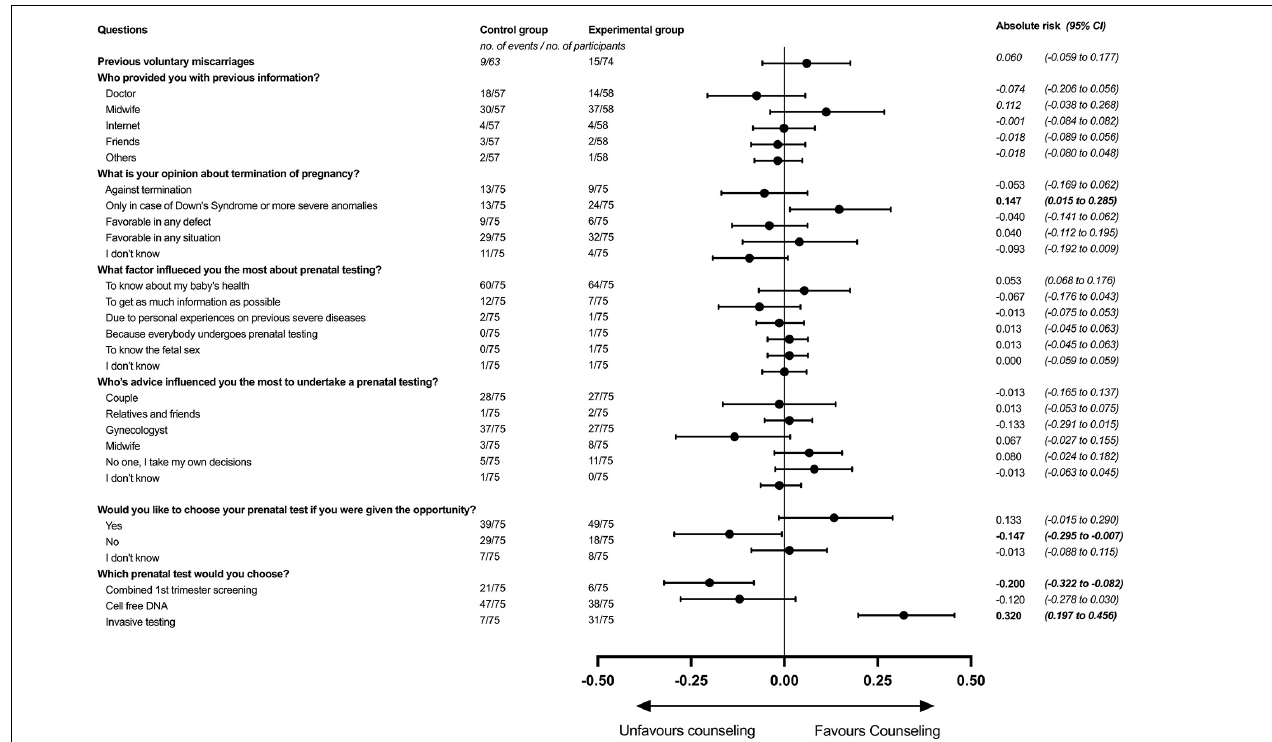
FIGURE 2 | Forest plot on the calculate absolute risk for each answer in the questionnaire comparing those women allocated in the intervention and control group. Numbers on the right side of the graph represent the absolute risk favoring counseling, while those answers on the left side favor no